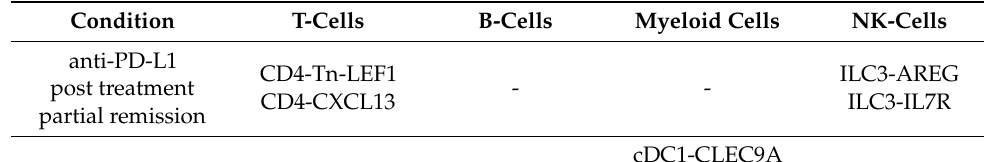
Table 2. Immune cell populations that are linked to the specific TNBC outcome determined by our informatics